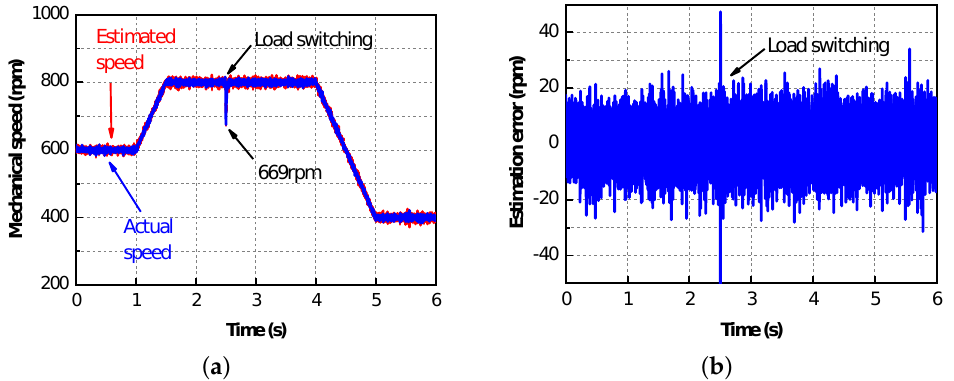
Figure 14. Simulation results of speed using the inductance matrix table. ( a ) Estimated speed and ( b ) estimation